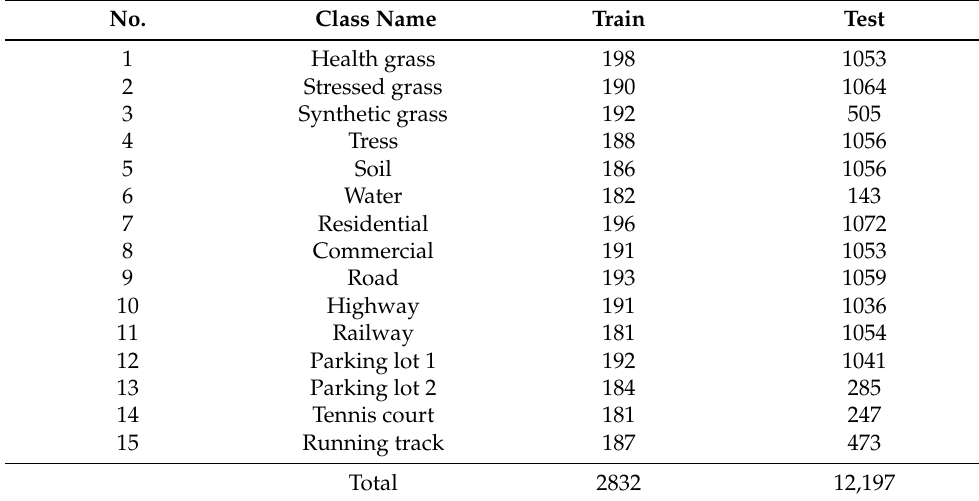
Table 2. Number of training and testing samples in GRSS-DFC-2013